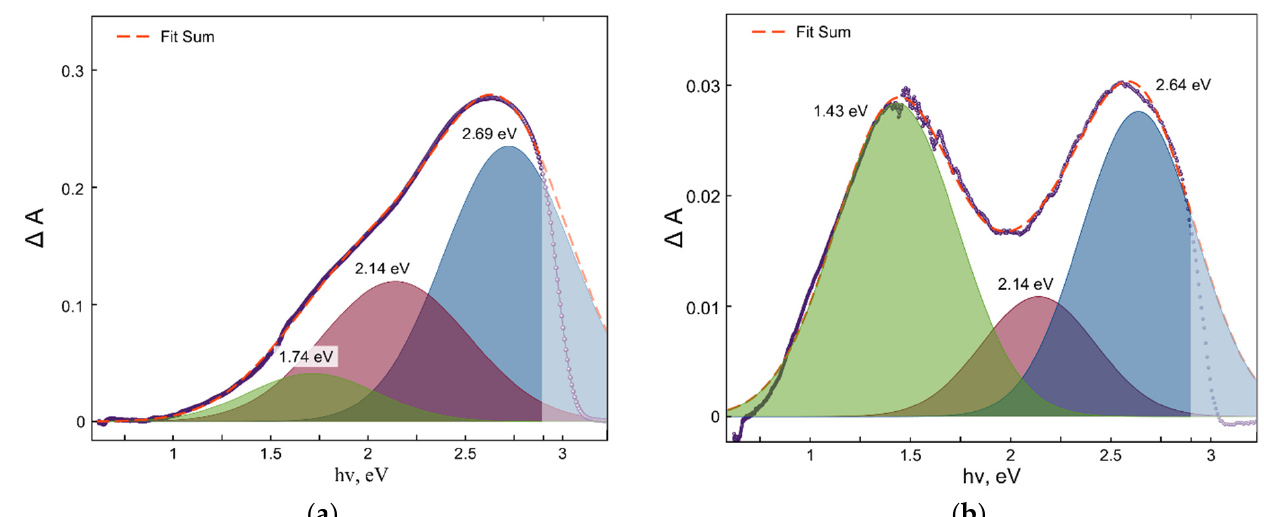
Figure 5. Deconvolution (red dashed lines) of the absorption spectra (blue solid lines) of photoinduced defects in ( a ) Sc-doped TiO 2 and ( b ) Nb-doped TiO 2 .